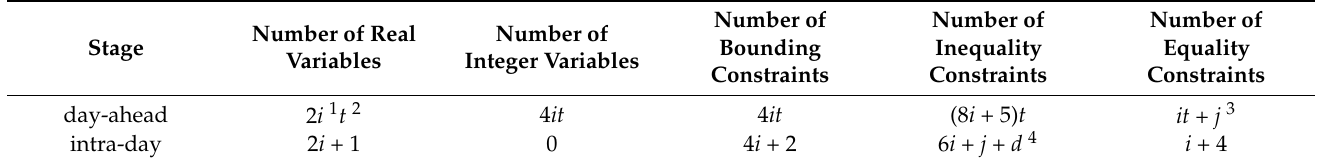
Table 1. The scale of each optimization